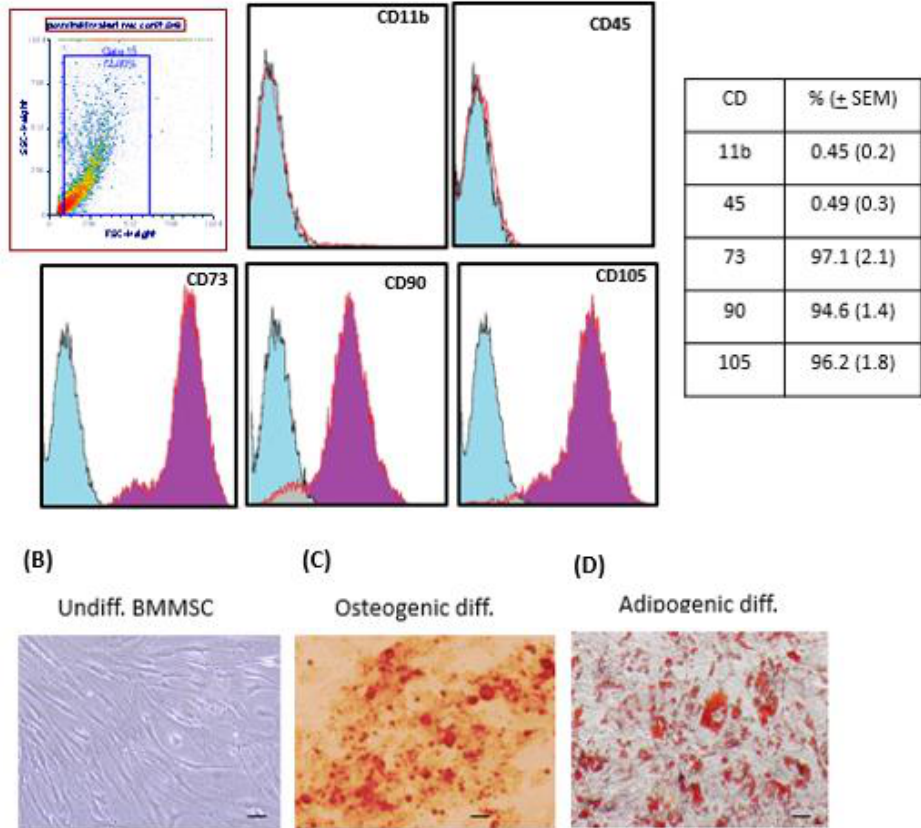
Figure 1. Bone marrow Mesenchymal Stem/Stromal cells characterization ( A ) BMMSC, were sub- jected to immunophenotyping. Analysis of flow cytometry histogram of BMMSCs for mesenchymal stem cell (CD90, CD73, and CD105) and leukocyte (CD11b and CD45) markers are indicated. Blue light areas indicate background fluorescence obtained with isotype control, and the red-line histogram indicates signal for each specific antibody. Table indicated the average values for the determined cell surface markers. Results presented are representative from at least 3 experiments performed. ( B ) morphology of undifferentiated BMMSC ( C ) osteogenic differentiation determined by alizarin red staining for extracellular matrix mineralization; ( D ) adipogenic differentiation analysed by oil- red staining for cytoplasmic lipid drops accumulation. Magnification 40 × , Bars = 10 µ m. Results presented are representative from at least 3 performed